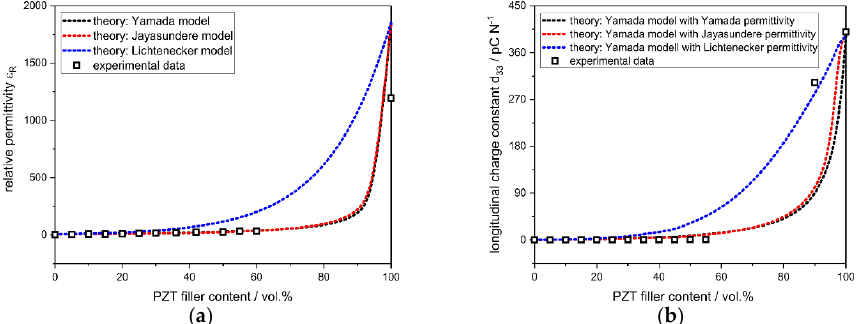
Figure 8. Experimental results for the relative permittivity ( a ) and the piezoelectric charge constant ( b ) of PZT-polymer composites, the pure polymer matrix, and the pure PZT filler. The experimental data could be modelled su ffi ciently using the models of Yamada and Jayasundere for the extrapolation of the permittivity and d 33